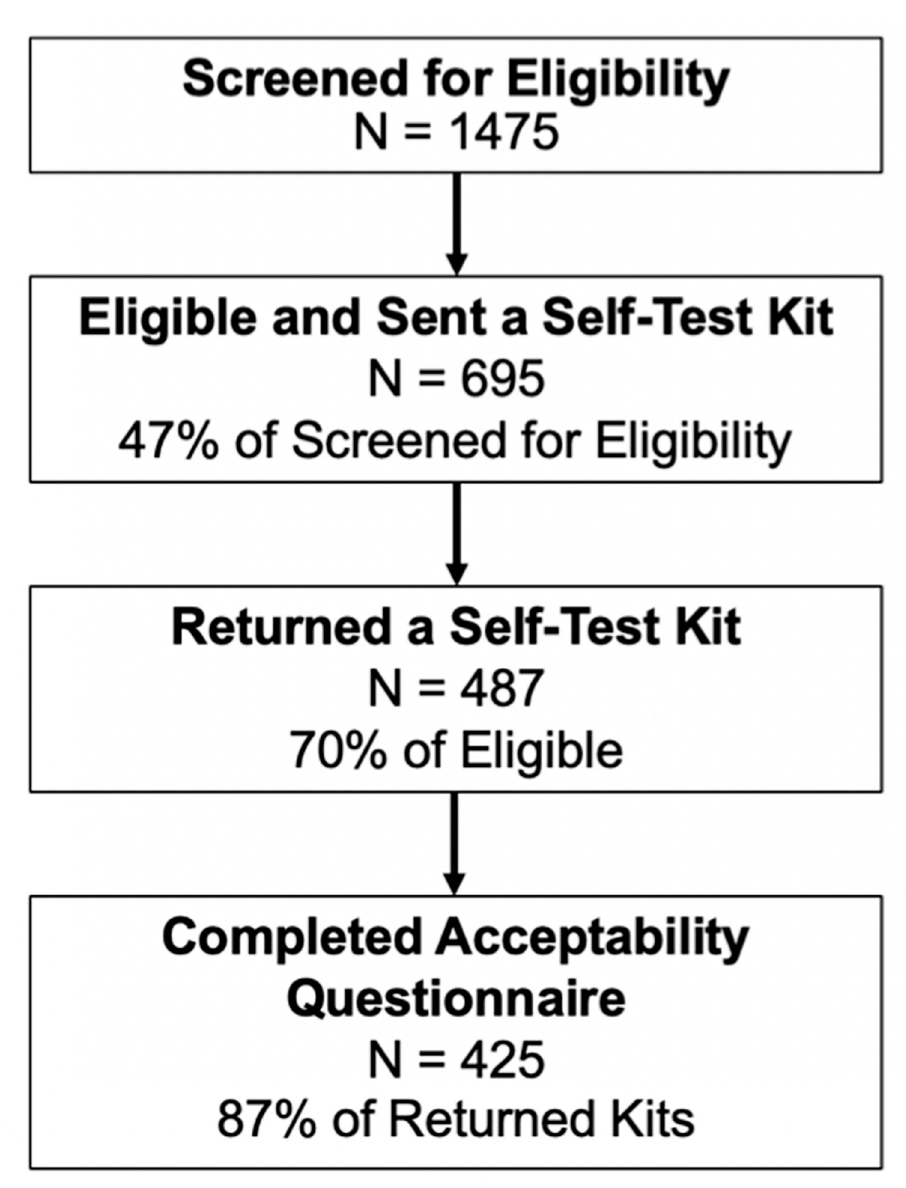
Fig 1. Overall progression of individuals through